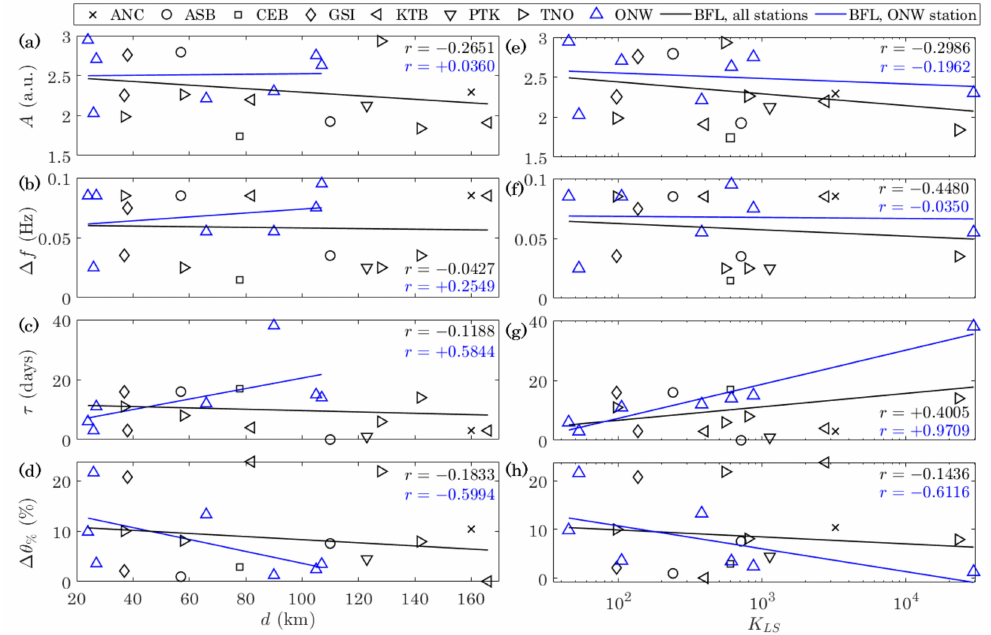
Figure 9. Similar to Figure 8, but for A , ∆ f , τ and ∆ ϑ % against epicentral distance ( d ) in ( a – d ); and against K LS in ( e – h ) where logarithmic scale is used for x